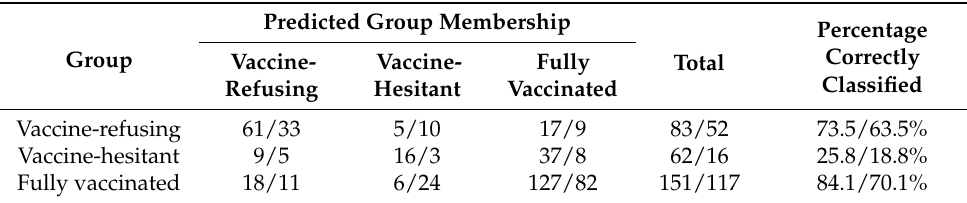
Table 3. Accuracy of the discrimination in the training and the test